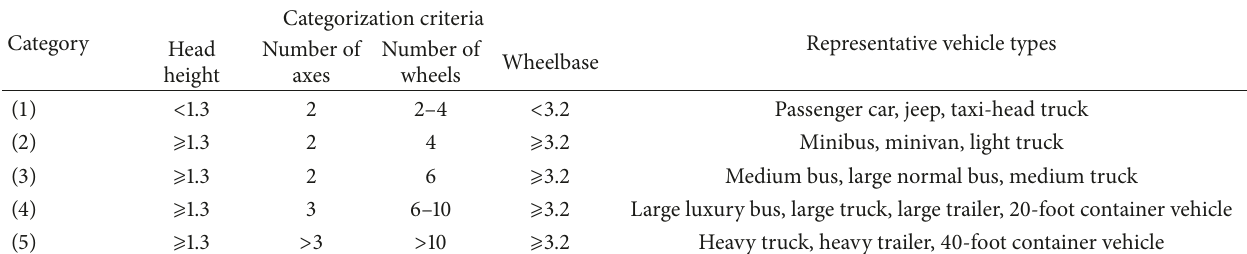
Table 1: Vehicle